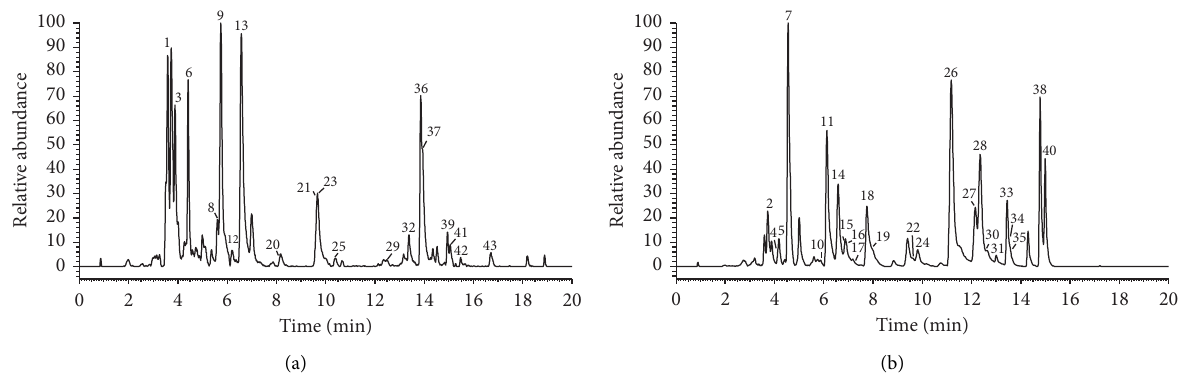
Figure 1: The high-resolution extracted ion chromatogram (HREIC) in 5ppm for the multiple compounds in Potentilla freyniana Bornm. (a) m/z 269.0455, 283.0612, 285.0405, 301.0354, 303.0510, 431.0984, 465.1038, 479.0831, 565.1563, 567.1719, 593.1512, 625.1408; (b) m/z